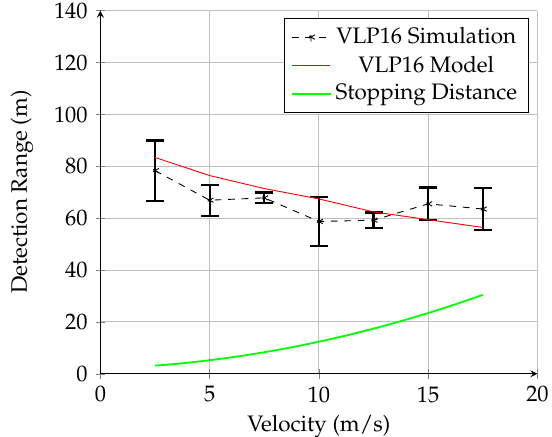
Figure 7. Results for the UAV-mounted VLP-16 sensor. The red line is the analytical model, the black line is the simulation, and the green line is the stopping